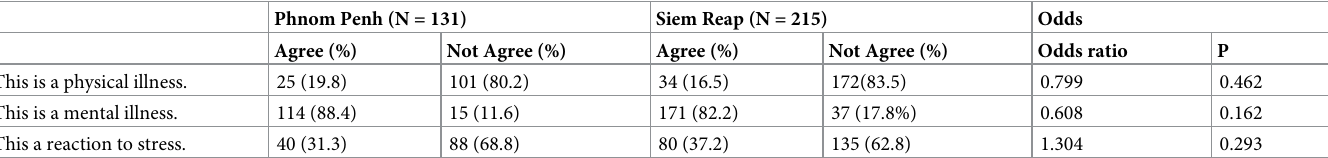
Table 1. Participants’ basic understanding of schizophrenia. Phnom Penh (N =